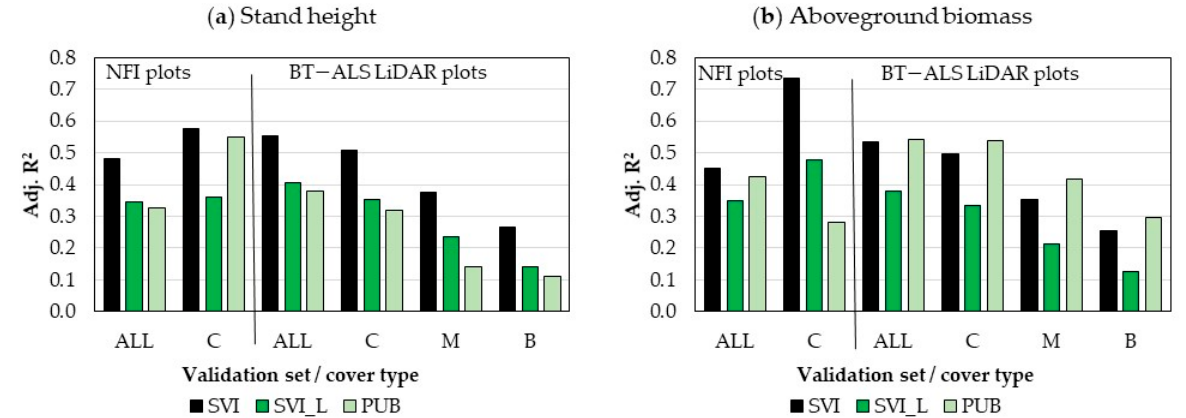
Figure 8. Goodness of fit (adj. R 2 ) for ( a ) stand height and ( b ) AGB relative to the validation datasets comprising NFI plots and BT − ALS LiDAR plots using all samples (ALL) then partitioned by forest cover type (C: conifer, M: mixedwood, B: broadleaf) for SVI maps compared to Landsat-based SVI_L maps and published (PUB) maps.